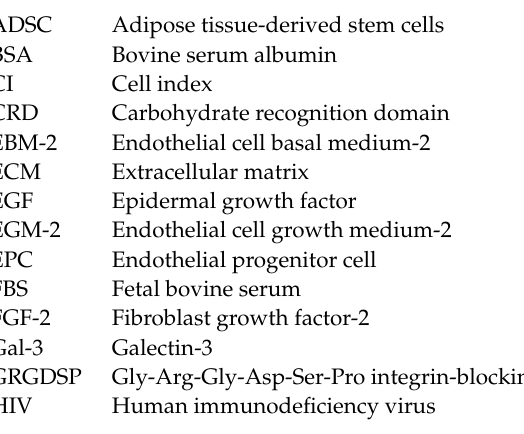
xCELLigence system four hours after seeding. Figure S2: The effect of LacdiNAc on the spreading of ADSCs four hours after seeding into untreated wells or wells preadsorbed with 1 µ M Gal-3 and blocked with BSA. Figure S3: Role of integrins in the spreading of ADSCs and HUVECs on substrate-immobilized Gal-3 (four hours after seeding). Figure S4: Cell surface expression of integrins on ADSCs. Figure S5: Cell surface expression of integrins on HUVECs. Figure S6: Adhesion of ADSCs on wells one hour after seeding in a medium containing various concentrations of the α V β 1 inhibitor. Figure S7: Fluorescence staining of ADSCs and HUVECs adhered to various protein-coated glass surfaces 4 h after cell seeding (objective magnification 40 × ). Figure S8: Fluorescence staining of ADSCs and HUVECs adhered to various protein-coated glass surfaces four hours after cell seeding (objective magnification 100 × ). Figure S9: The morphology characteristics of ADSCs and HUVECs adhered to various protein-coated glass surfaces four hours after